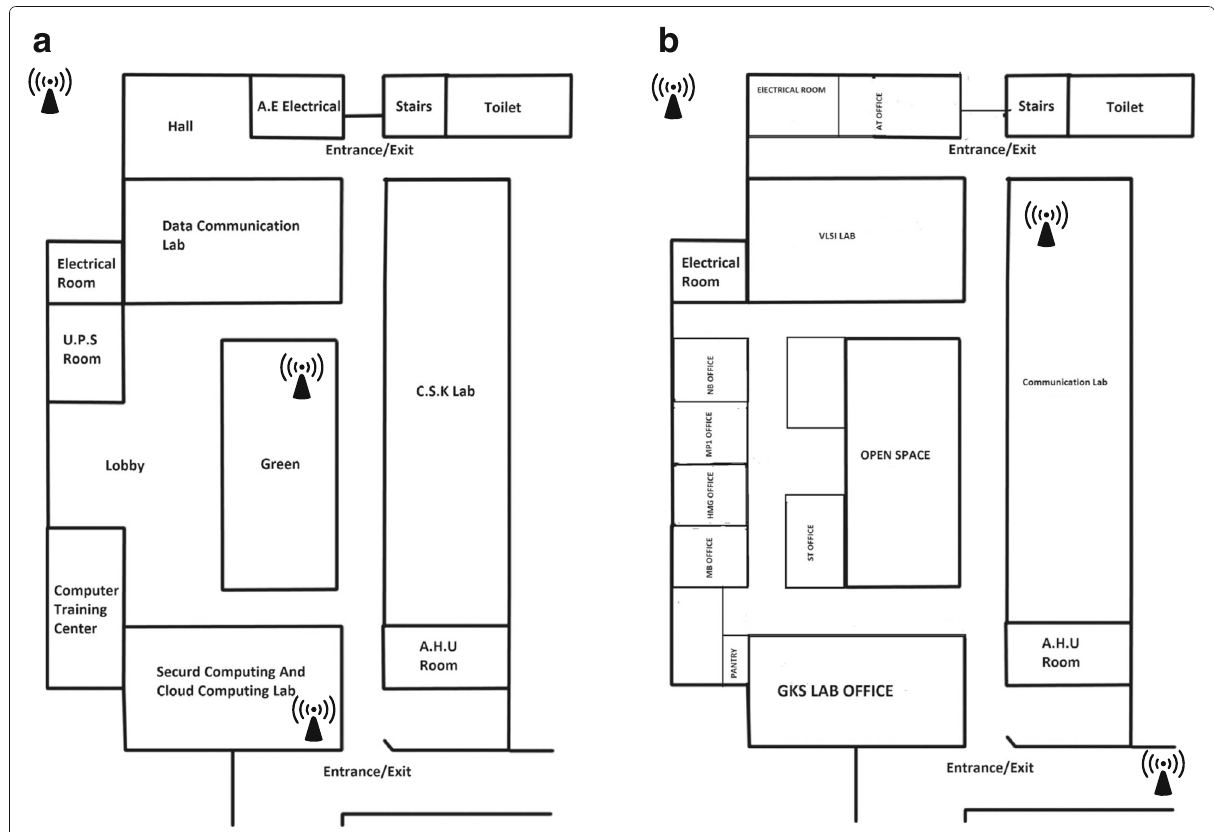
Fig. 1 a Distribution of AP’s in testbed-1 b Distribution of AP’s in testbed-2